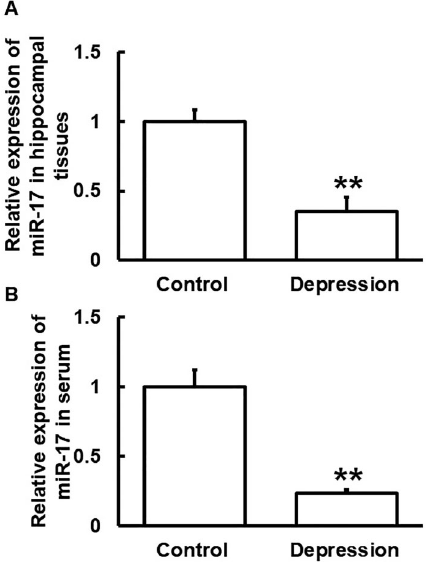
Figure 4. Relative expression of miR-17 in ( A ) hippocampal tissues and ( B ) serum from mice in the control and depression groups. Expression of miR-17 was determined by qRT-PCR. Data are reported as means ± SD. **P o 0.01 compared with control ( t -test).